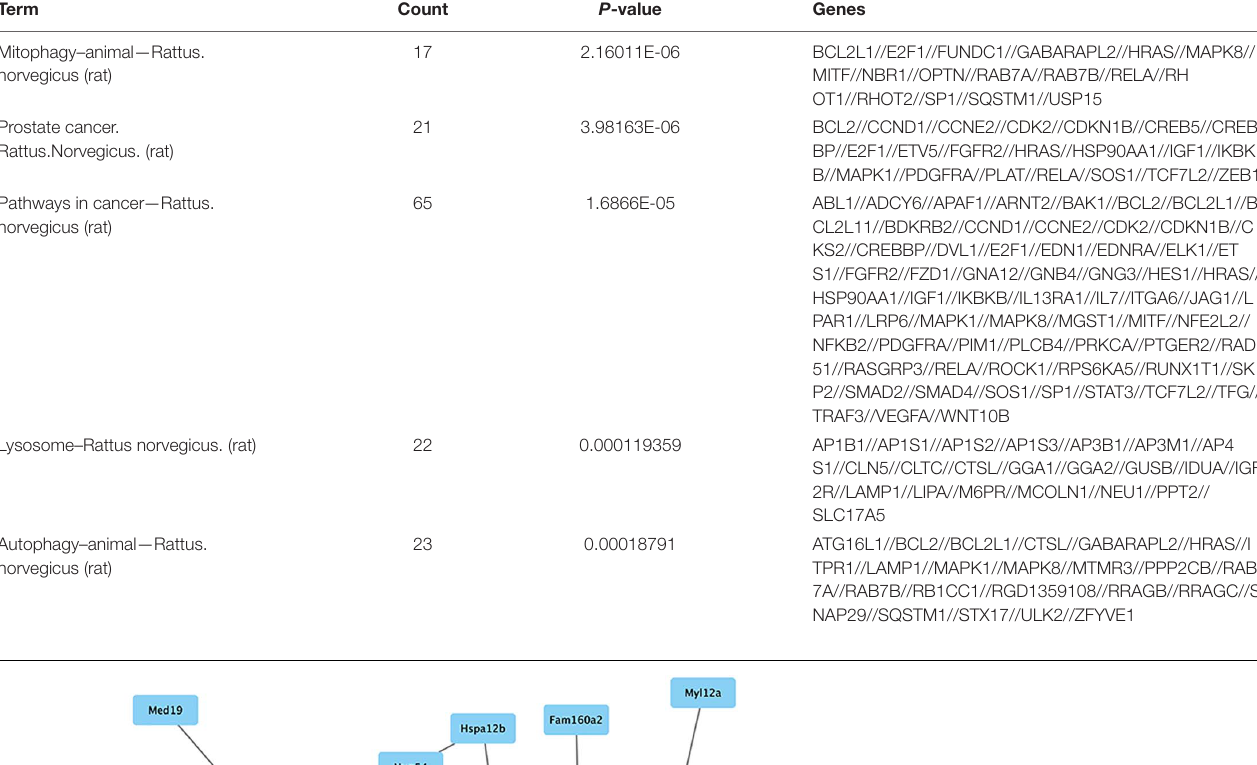
TABLE 3 | The top five (ranked by P -value) KEGG pathways. Term